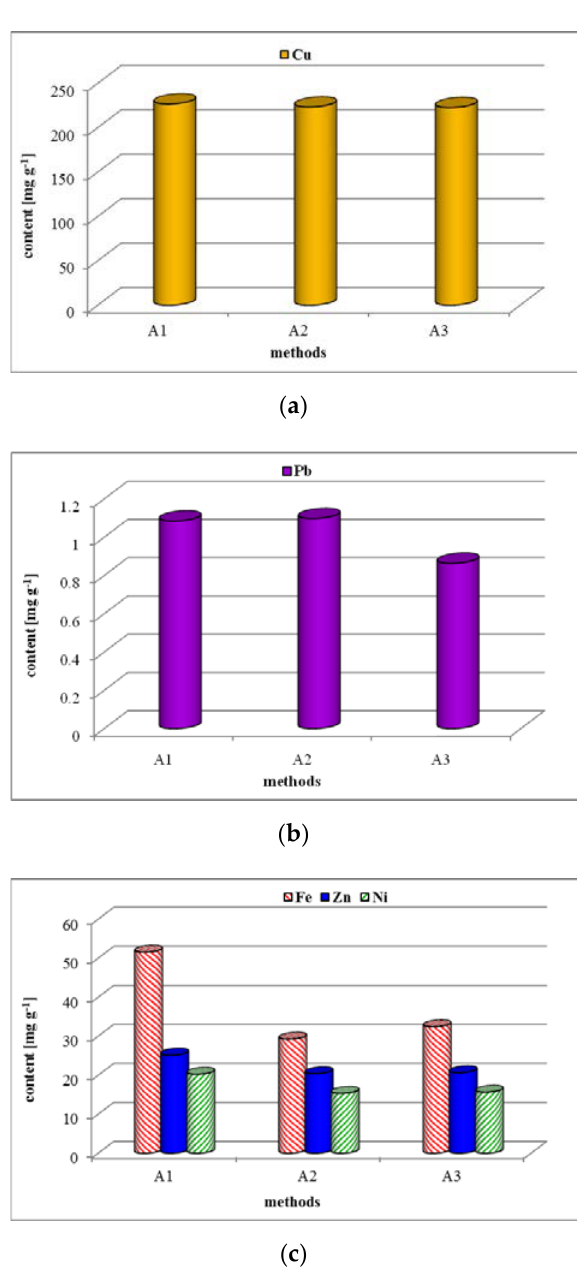
Figure 3. Content of Cu ( a ), Pb ( b ), Fe ( c ), Zn and Ni in post-digestion solutions obtained by application of the US EPA 3052 method (A1) and its modifications in time (A2, A3) on mobile phone PCBs.